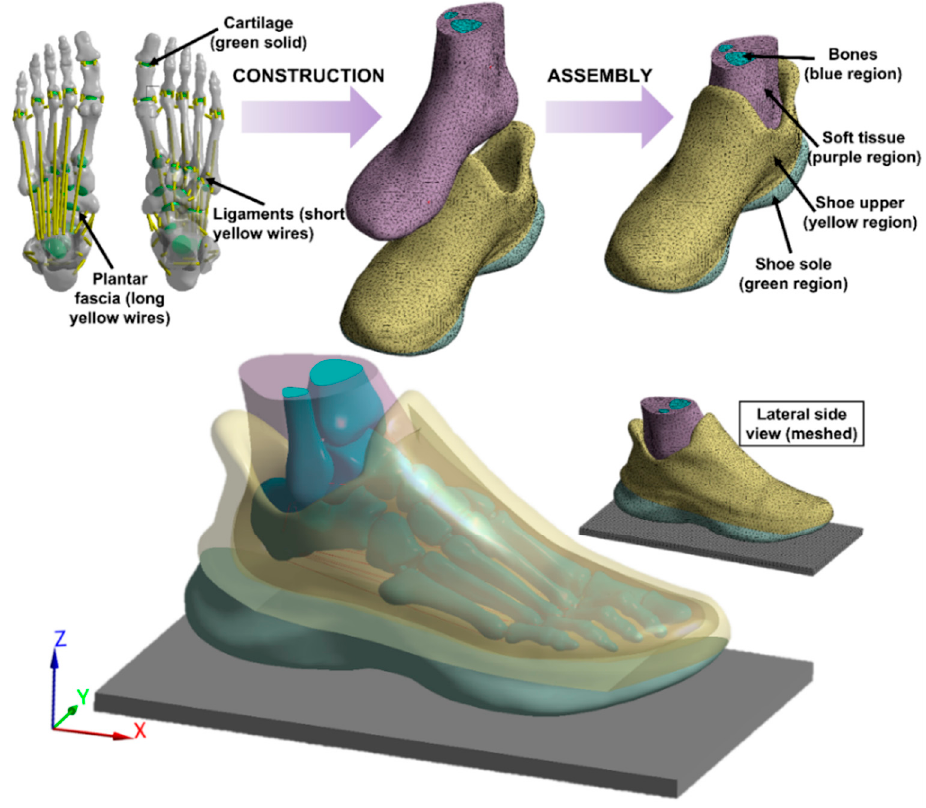
Figure 1. Three-dimensional finite element model of the foot and sports shoe complex. The model started from the reconstruction of each solid part of the foot and shoe, and then, the main two parts (foot and shoe) were assembled together to form the finial structure, which includes foot bone, car- tilage, ligament, plantar fascia, soft tissue, shoe upper, and shoe